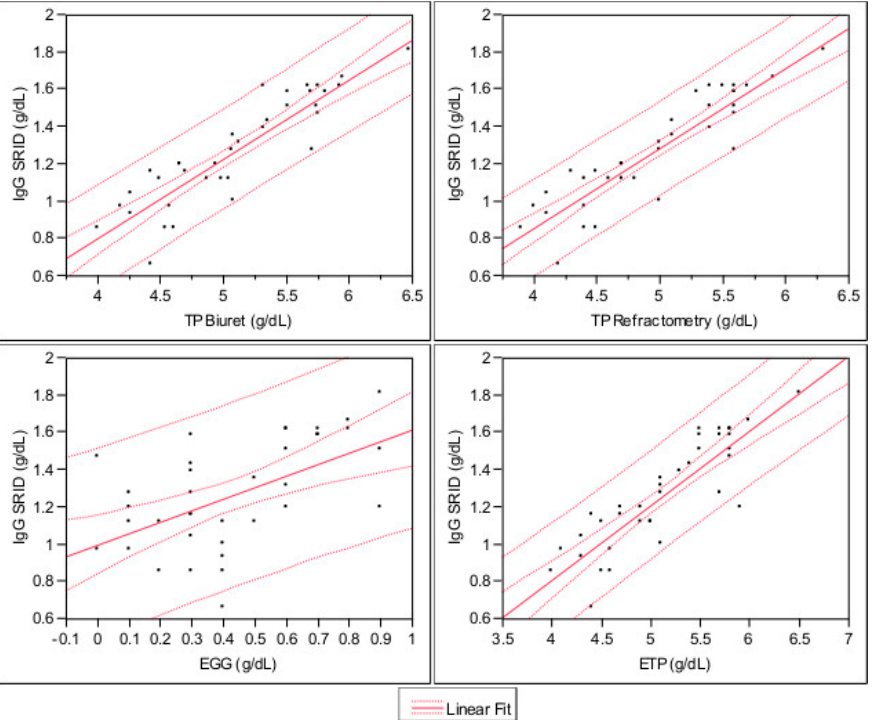
Figure 1. Confidence interval of each methods investigated. Internal dashed lines = Prediction lines. External dashed lines = Confidence lines. Legend: IgG SRID—immunoglobulin type G evaluated by the single radial immunodiffusion; TP Refractometry– total protein evaluated by refractometry; EGG—electrophoresis gamma globulin; ETP—electrophoresis total